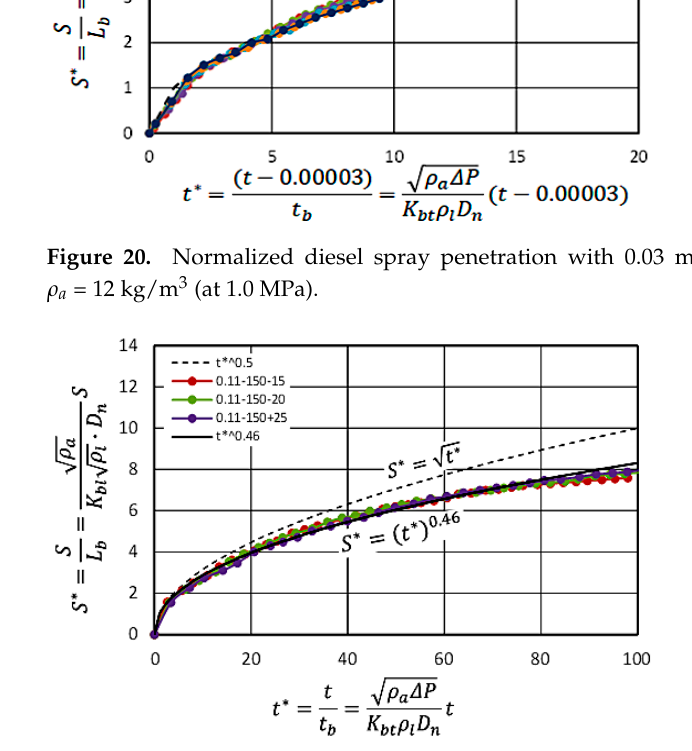
Figure 21. Normalized spray penetration of 150 MPa injection under 15, 20 and 25 MPa surroundings. Nozzle diameter is 0.11 mm. The dashed line corresponds penetration of similarity law equation with 𝑆 ∗ = √𝑡 ∗ and solid line is S * = ( t * ) 0.46 . Penetration data are reconstructed from the literature [33].